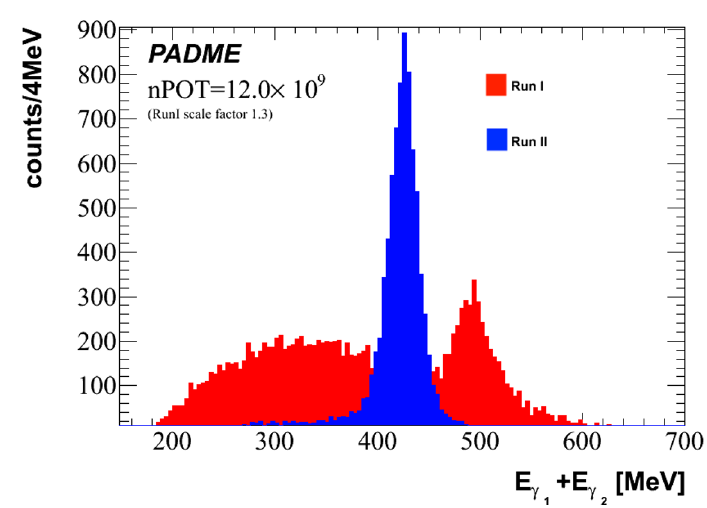
Figure 9 . Total energy of cluster pairs during different running